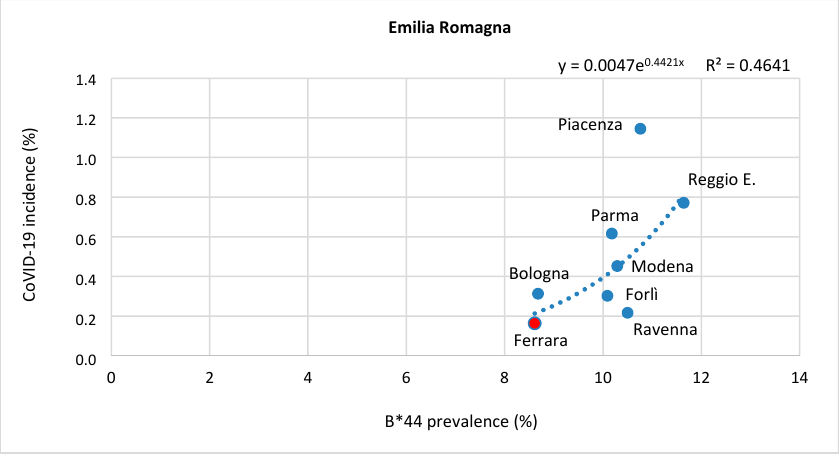
Table 2. – Multiple regression model: Covid-19 incidence rate and